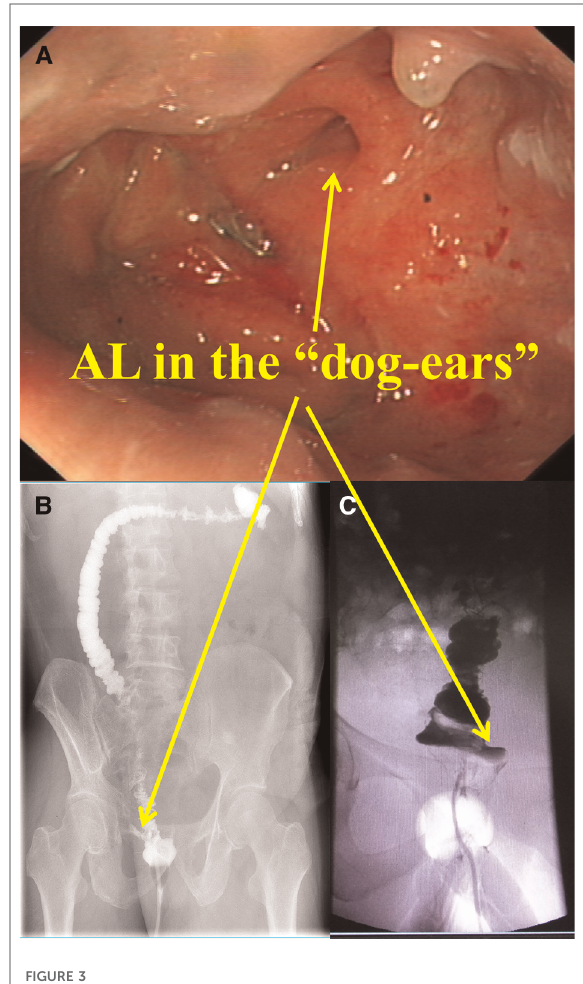
FIGURE 3 Diagram of AL. ( A ) The colonoscopy of the AL patinets. ( B ) and ( C ) The x-ray of the AL